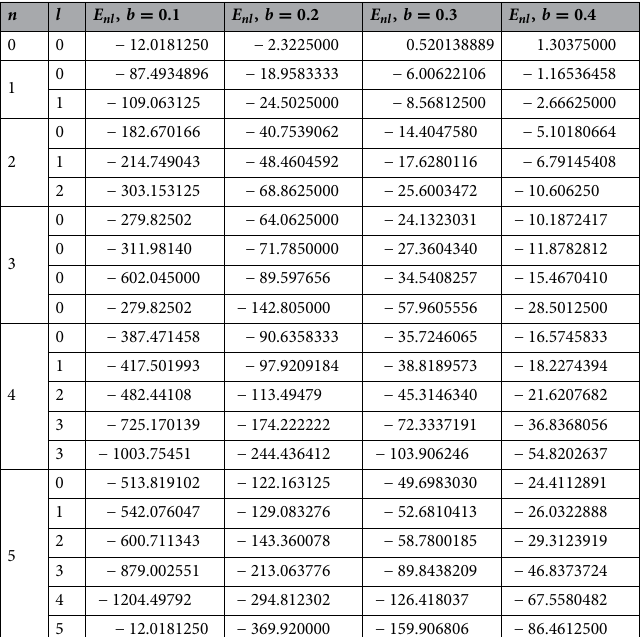
1 , v 1 , b 5 fm 15 fm 0.1, ( (cid:31) 1 − − = = =